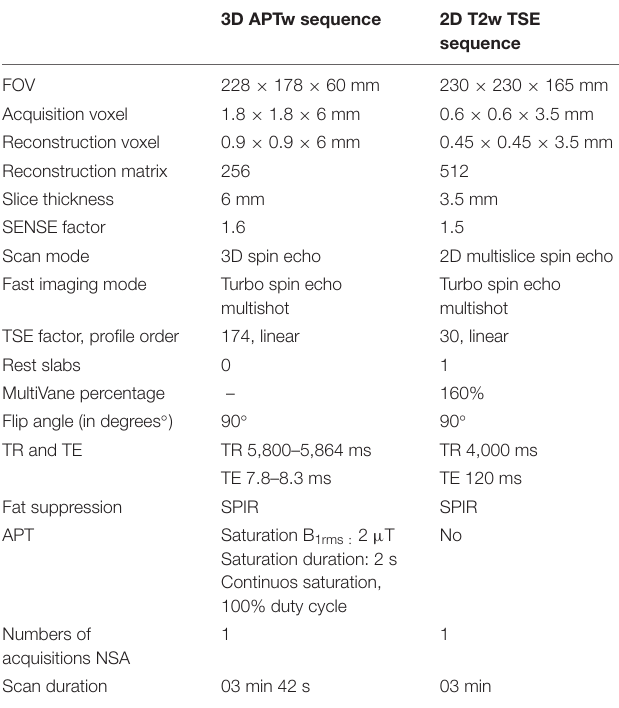
TABLE 1 | Scan parameters of APTw sequence and of 2D T2w TSE